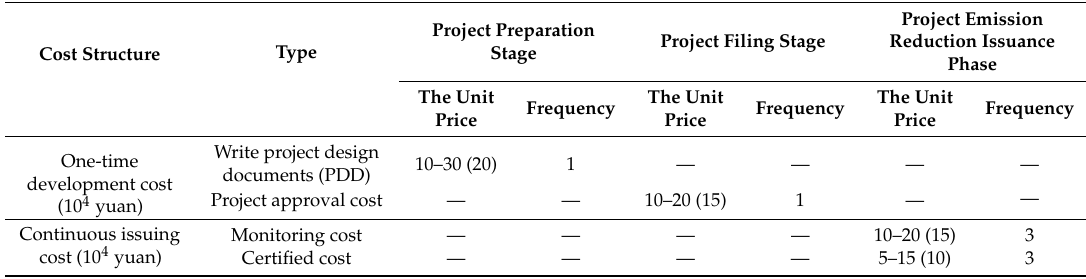
Table 2. The carbon sink transaction costs of a ff orestation project for carbon